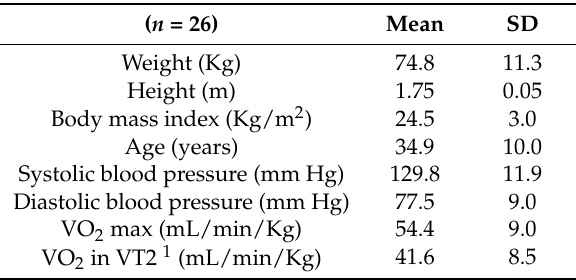
Table 1. Baseline demographic and clinical characteristics of participants. Values are presented as the mean with standard deviation (SD).